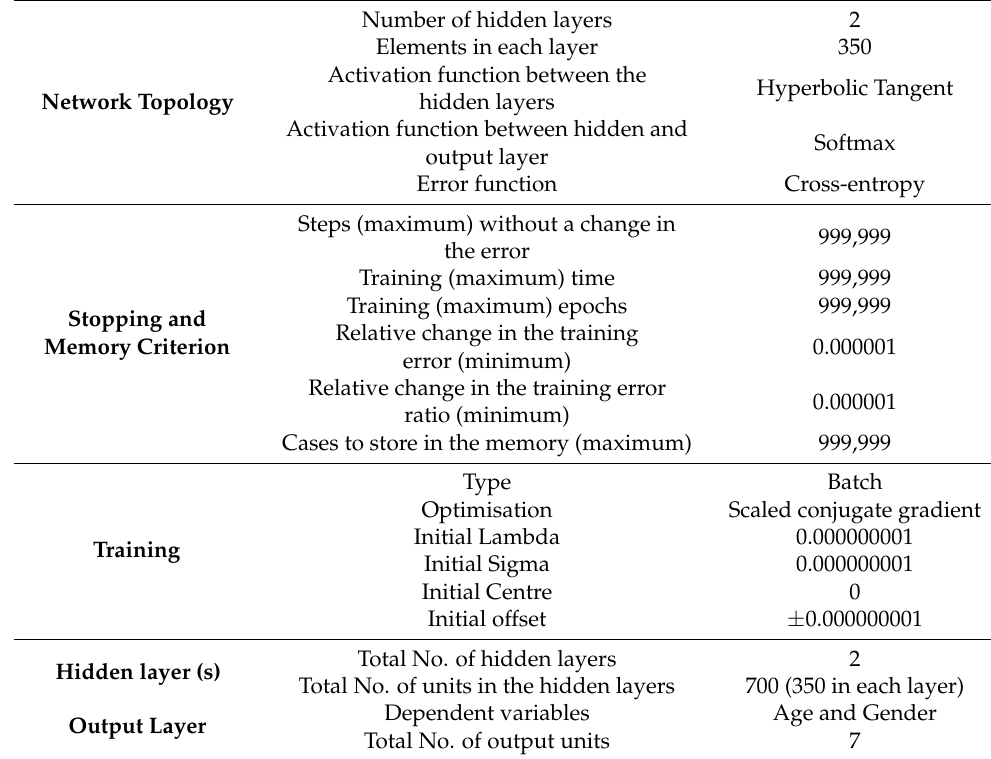
Table 3. Deep learning network